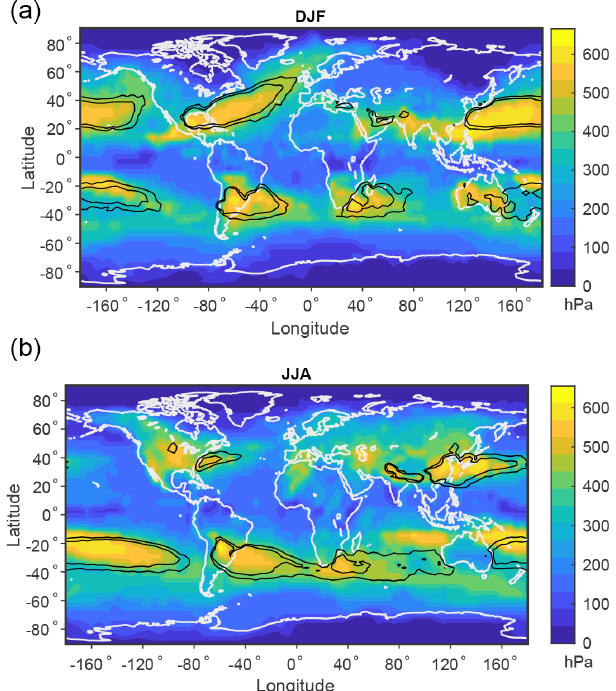
Figure 7. Maximum potential ascent in local nonconvective MAPE based on the climatological mean over 1979–2018 (color shading) and WCB starting-point frequency over 1979–2018 (black contours of 1% and 2%) for (a) DJF and (b) JJA. Nonconvective MAPE is calculated as in Fig. 5. Maximum potential ascent is calculated at each surface location as the maximum of pressure minus reference pressure for any parcel in the column at that surface location over all the nonconvective MAPE calculations that include that location. The WCB starting-point frequency is shown as the percentage of 6-hourly time steps in which a WCB begins at a given location in the climatology of Madonna et al.